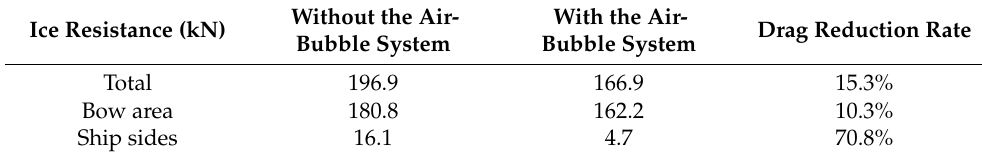
Figure 9. Time series of ice resistance when the air-bubble system is off: (top) total ice resistance; (middle) ice resistance from the bow area; (bottom) ice resistance from the sides. Table 3. Ice resistance of the stable stage.